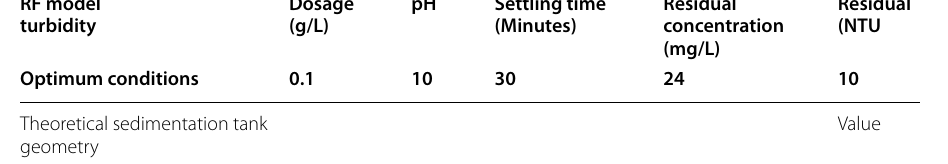
Dosage pH Settling time (g/L) (Minutes)